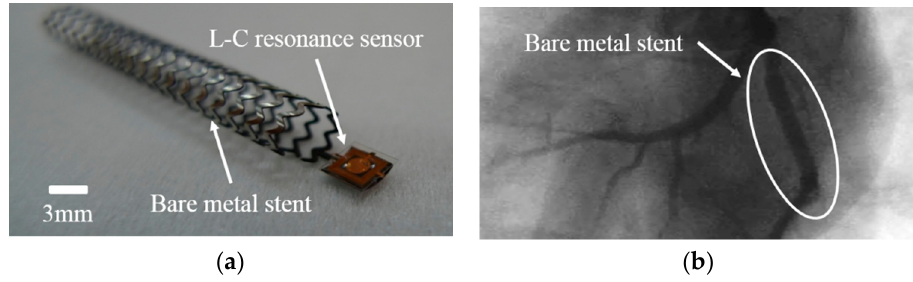
Figure 5. ( a ) Optical image of bare metal stent integrated with the wireless pressure sensor; and ( b ) X-ray image of animal test for the biocompatibility of the pressure sensor.